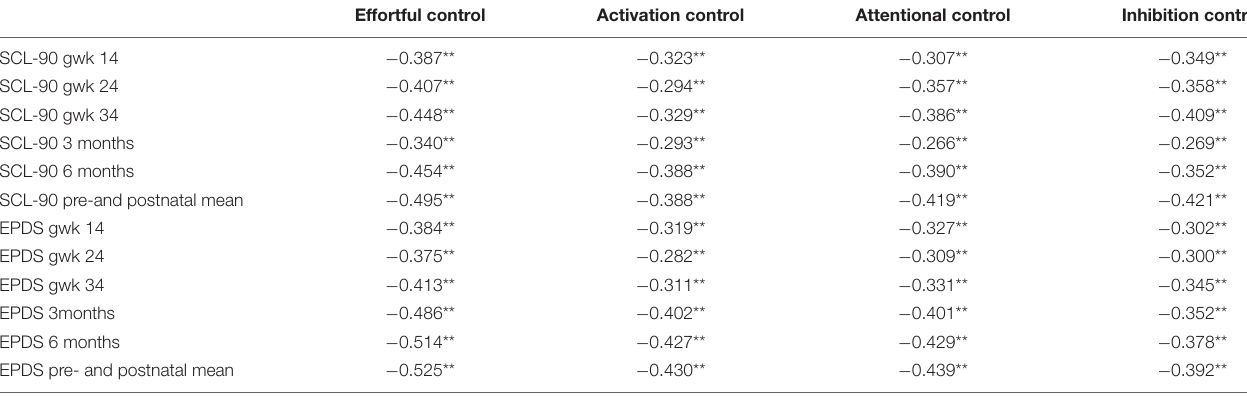
TABLE 6 | Spearman correlations between maternal anxiety and depressive symptoms and self-regulation capacity ( n = 123). Effortful control Activation control Attentional control Inhibition control